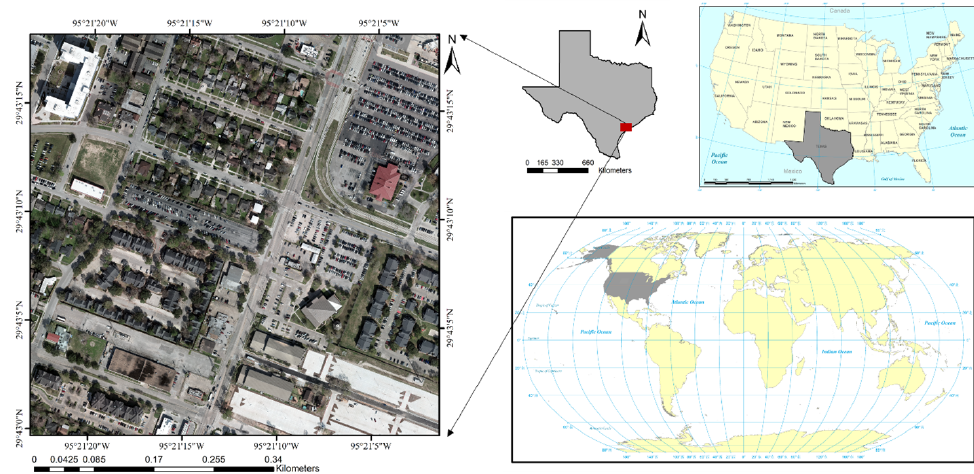
Figure 1. Study area location and RBG images.